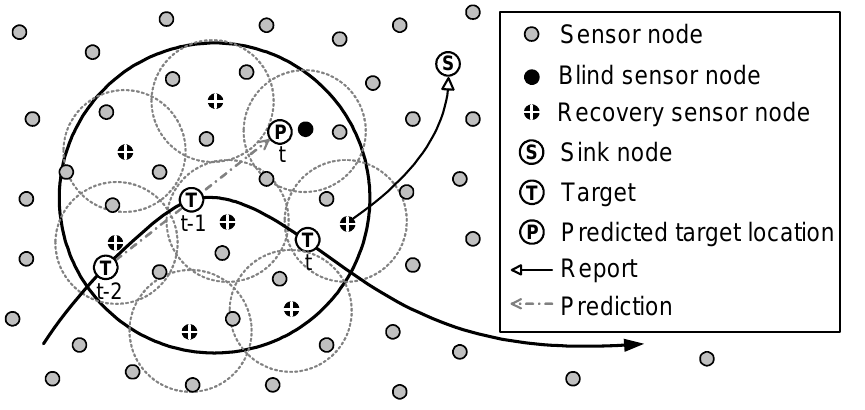
Figure 4 . Recovery mechanism for target tracking failure.